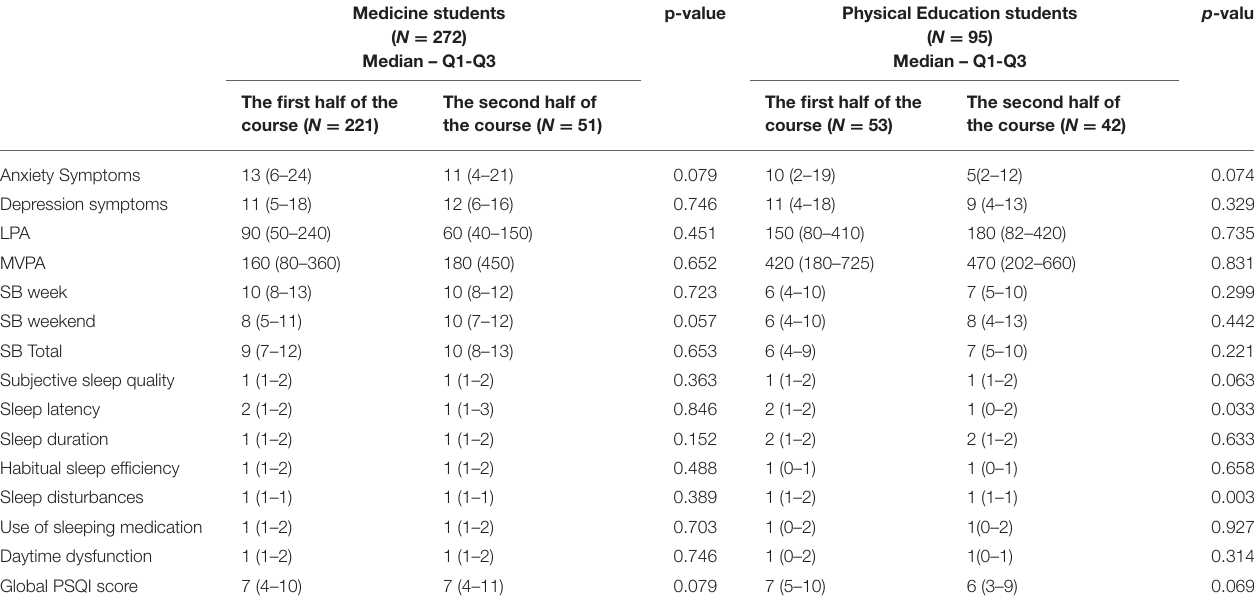
TABLE 3 | Comparisons (Mann-Whitney Test) between the first and second halves of the courses (1st to 4th and 5th to 8th in PE; 1st to 6th and 7th to 12th in MED) regarding anxiety symptoms (Beck Anxiety Inventory - BAI), depression symptoms (Beck Depressive Inventory - BDI), level of physical activity and sedentary behavior (IPAQ).